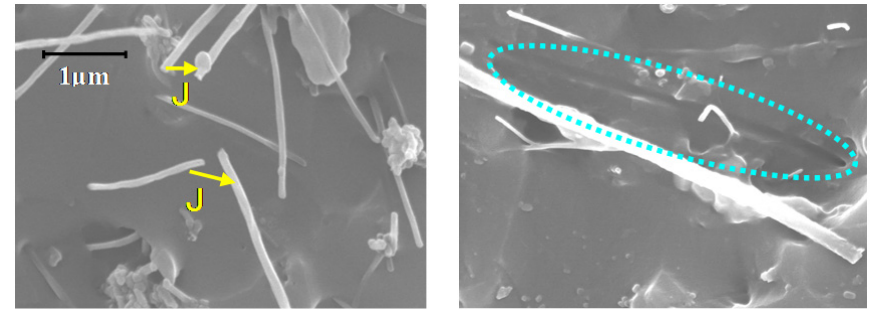
Figure 9. SEM images of possible tunneling effect among CNTs and evidence of weak interface between polymer and CNTs in